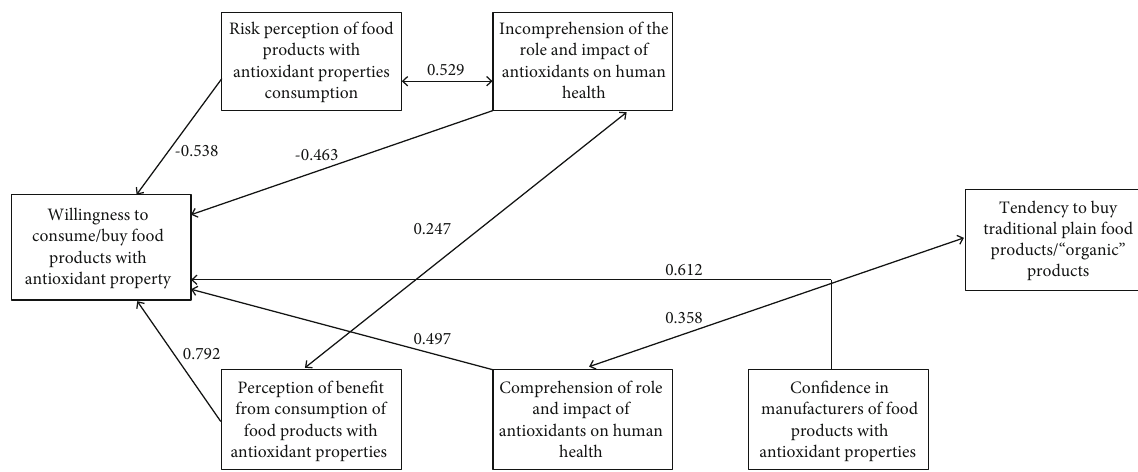
Figure 2: Estimation model with standardized correlation coe ffi cients ( p < 0 : 05